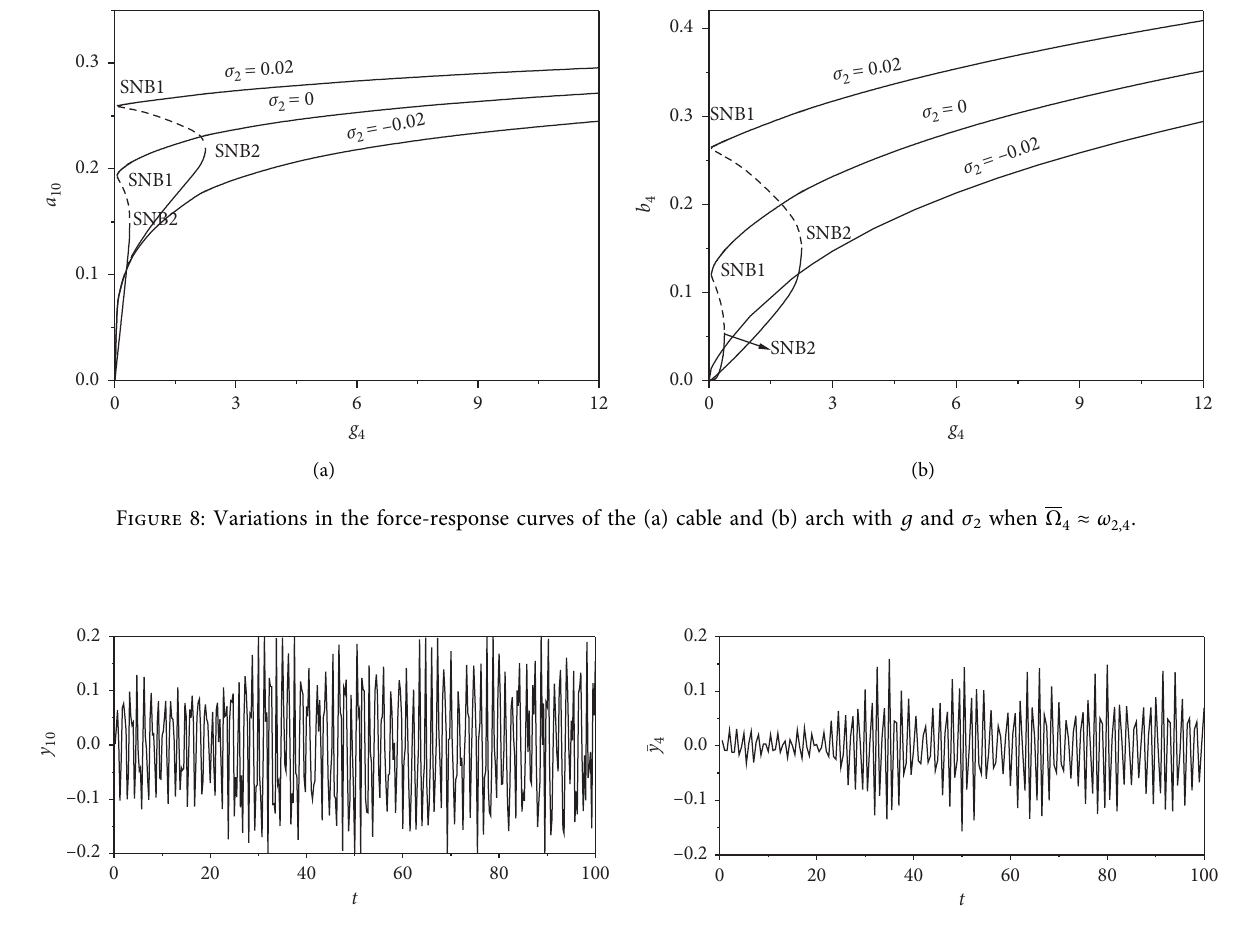
Figure 9: Time histories of cable (a) and shallow arch (b) with σ